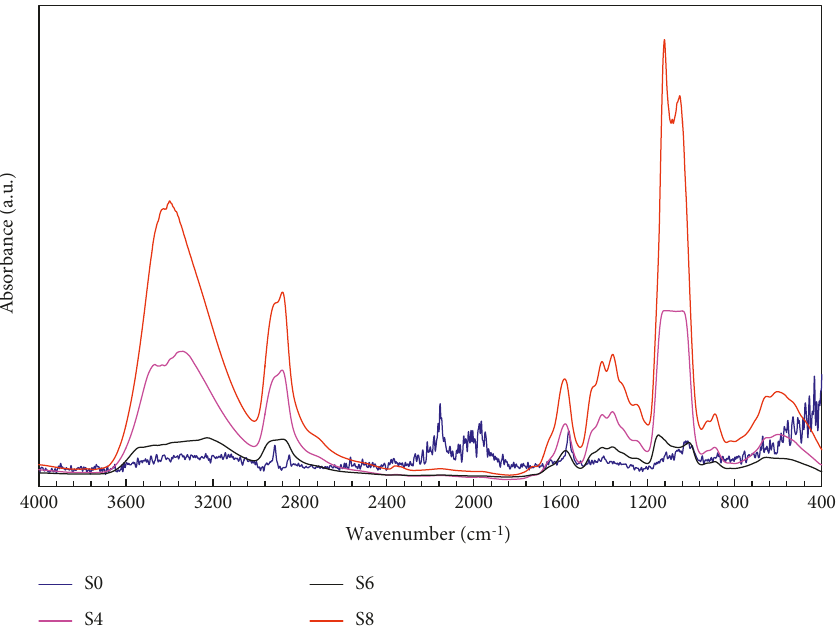
Figure 3: FTIR spectra of CuONPs-doped HEC